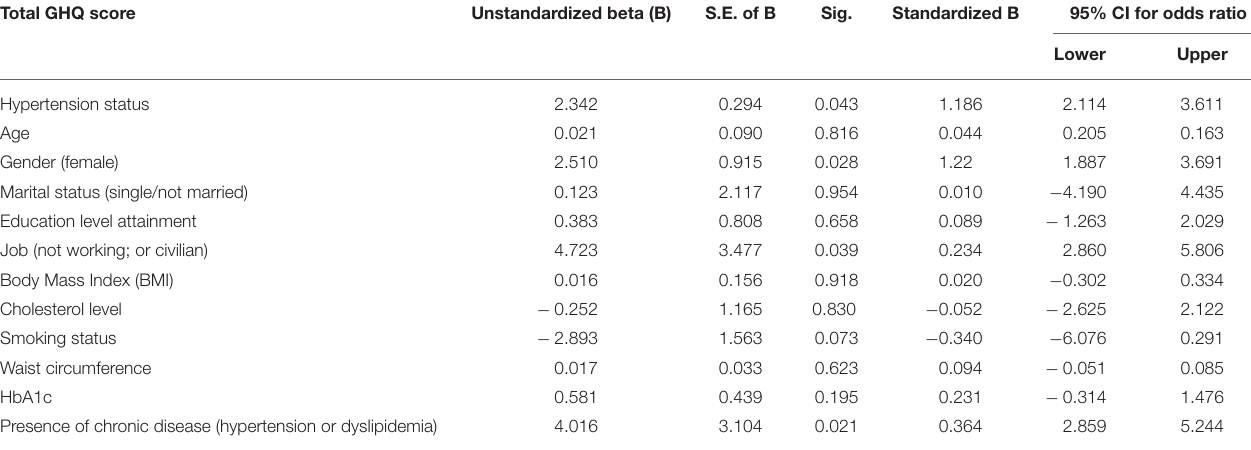
TABLE 4 | Multiple linear regression model regressing total GHQ score on hypertension status, HBA1c, and other sociodemographic and diabetes risk factors in diabetic individuals ( n =